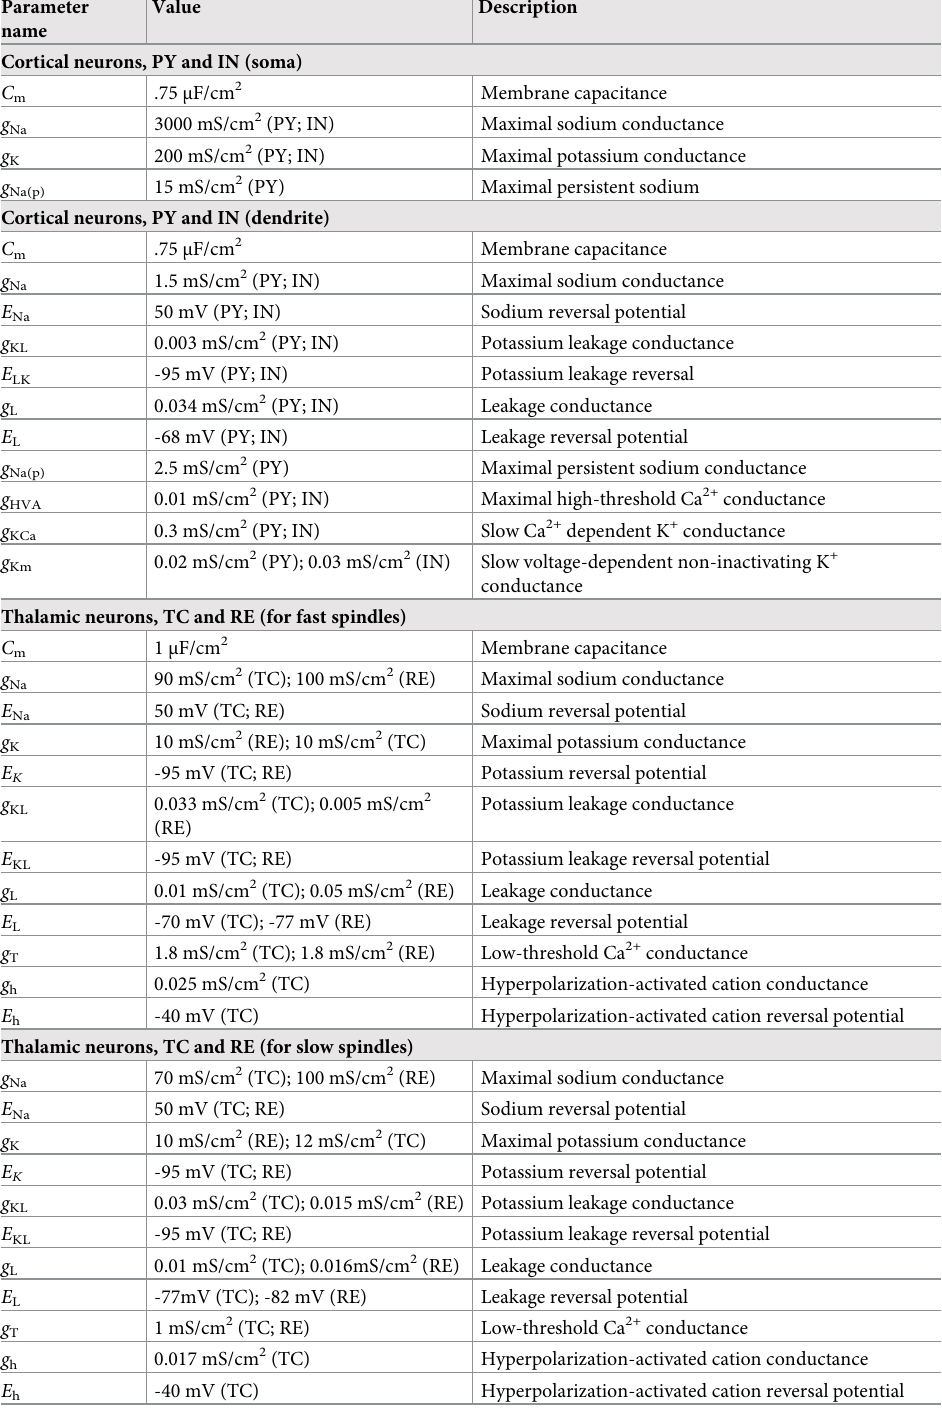
Table 2. Model parameters, their values, and